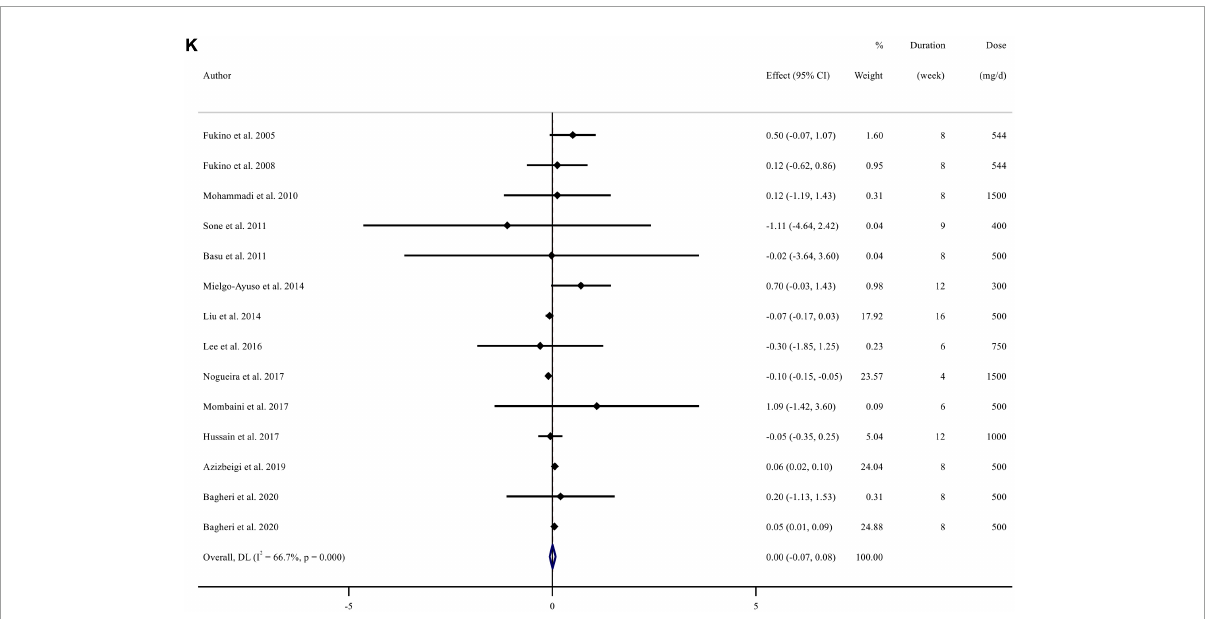
FIGURE2 Forest plot detailing weighted mean difference and 95% confidence intervals (CIs) for the effects of green tea extract supplementation on (A) TG (mg/dL); (B) TC (mg/dL); (C) LDL (mg/dL); (D) HDL (mg/dL); (E) FBS (mg/dL); (F) fasting insulin ( µ lU/ml); (G) HbA1c (%); (H) HOMA-IR; (I) SBP (mmHg), (J) DBP (mmHg); (K) CRP